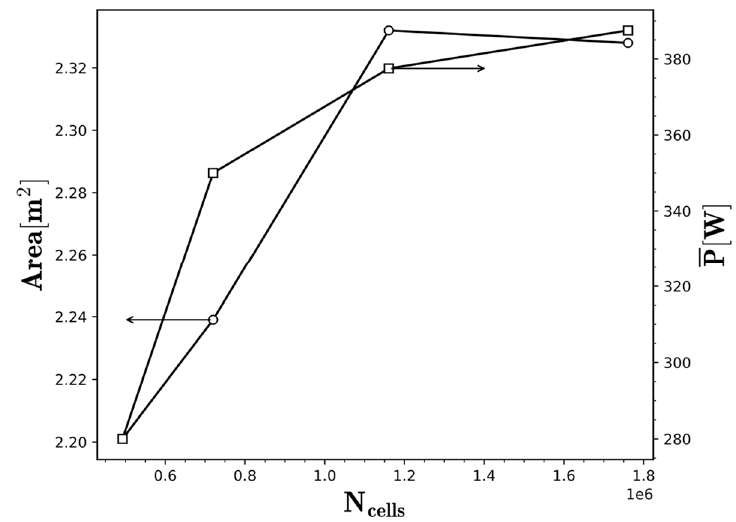
Figure 7. Mesh refinement effect for the industrial scale stirring tank at V = 1500 L and 100 rpm.